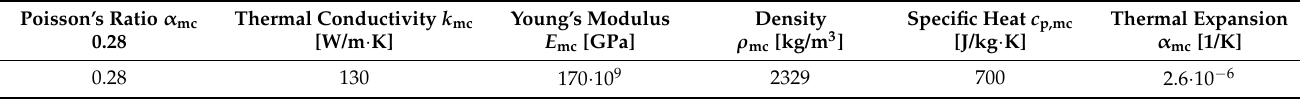
Table 2. The thermophysical properties of silicon.